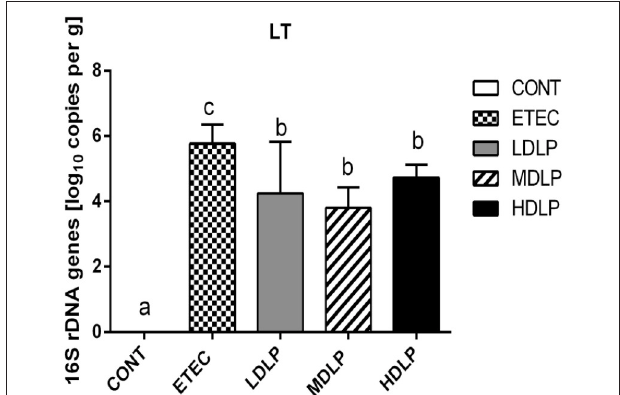
FIGURE 8 | Amount of LT gene in colon of mice at 24h after ETEC challenge. CONT, control group, treatment with PBS at all period; ETEC, negative group, oral challenge with ETEC on day 15; LDLP, low dose (5.0 × 10 8 cfu mL − 1 ) group; MDLP, intermediate dose (5.0 × 10 9 cfu mL − 1 ) group; HDLP, high dose (5.0 × 10 10 cfu mL − 1 ) group; LDLP, MDLP, and HDLP groups were infected with ETEC at day 15. Bars with different letters are significantly different ( P < 0.05). Bars share the same letters do not differ significantly ( P >